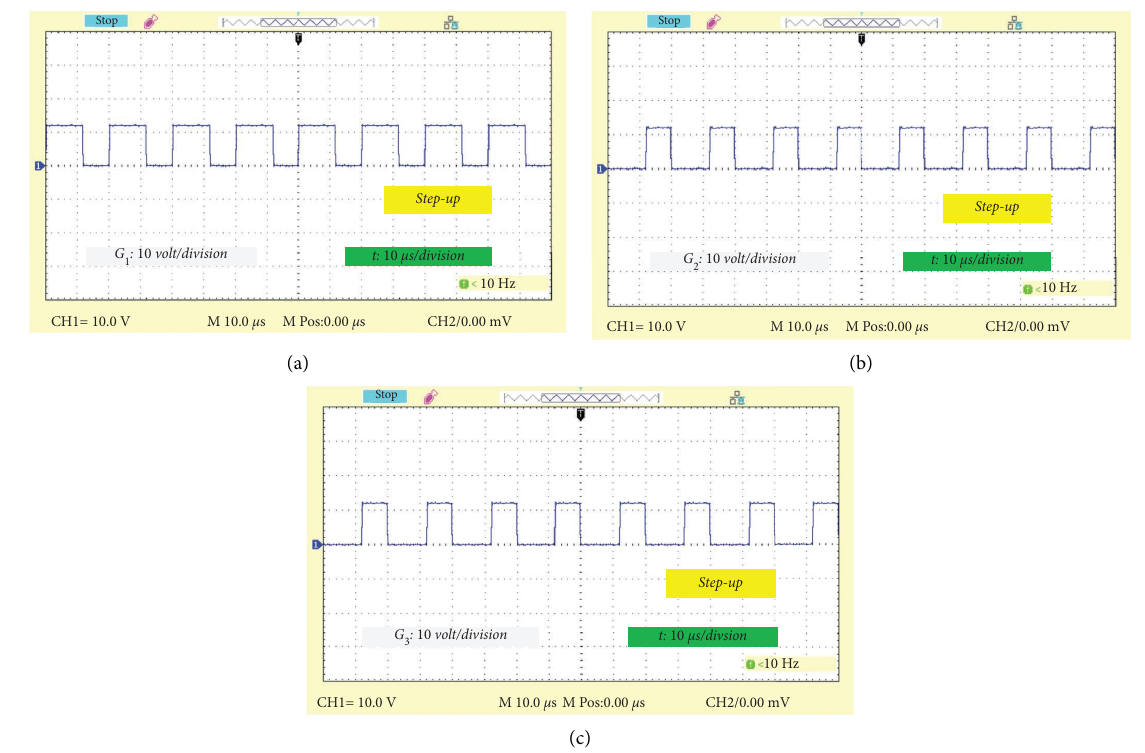
Figure 10: Gate pulses in step-up operation mode: (a) V